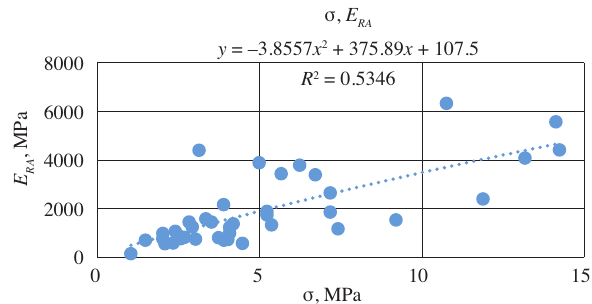
Figure 6. Relationship between compressive strength and modulus of elasticity of